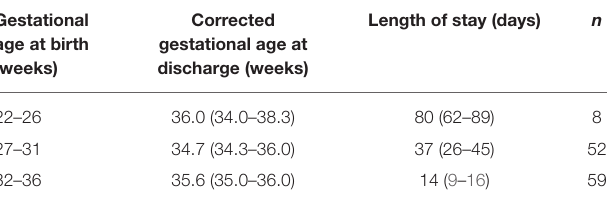
TABLE 3 | Gestational age at birth, median (IQR) corrected gestational age at discharge, and median length of stay (IQR). Gestational age at birth (weeks)